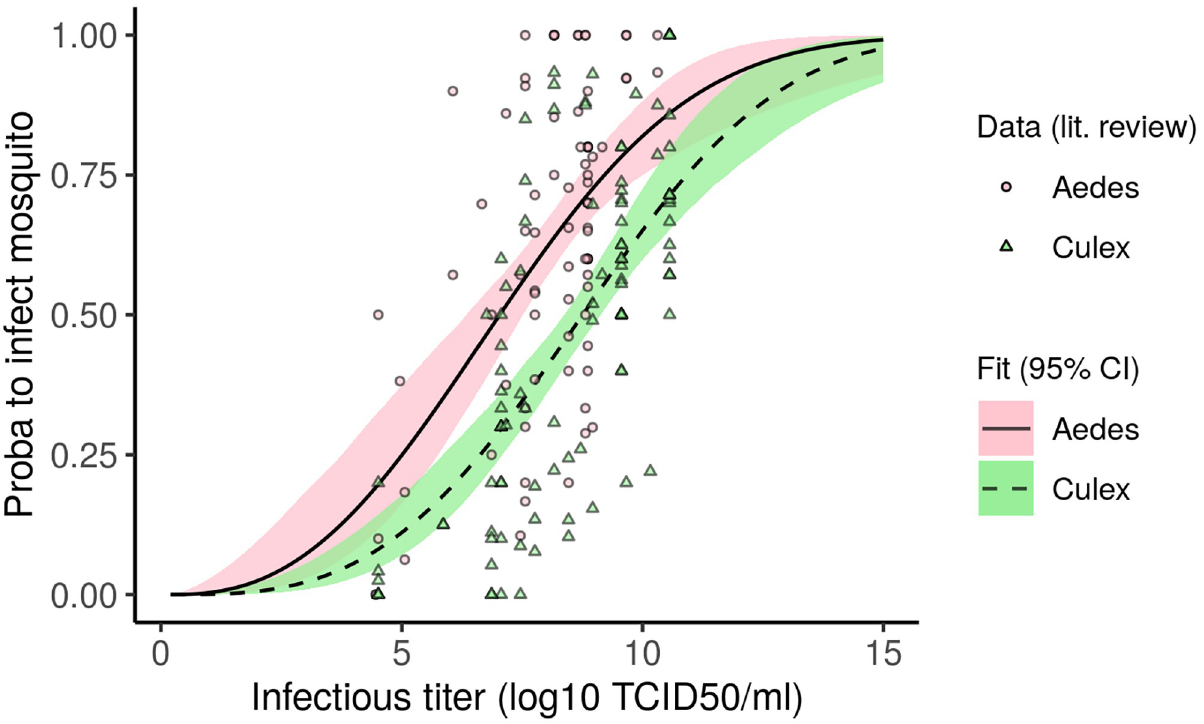
Fig 4. Dose-response relationships linking host infectious titers to the probability to infect mosquito vectors. Data retrieved from a systematic review (Materials and methods, Section S.2.1 in S1 Text). Points and triangles show infection rates (presence of RVFV in mosquito bodies, legs excluded) from experiments performed with hamsters with RVFV strain ZH501. Fits were obtained with Eq (S.6) in S1 Text using a betabinomial likelihood to account for overdispersal in the data. Confidence intervals result from 1000 replicate trajectories. Note that infectious titers > 10 log 10 TCID 50 /ml are not to be expected in hosts, but were included to show the full